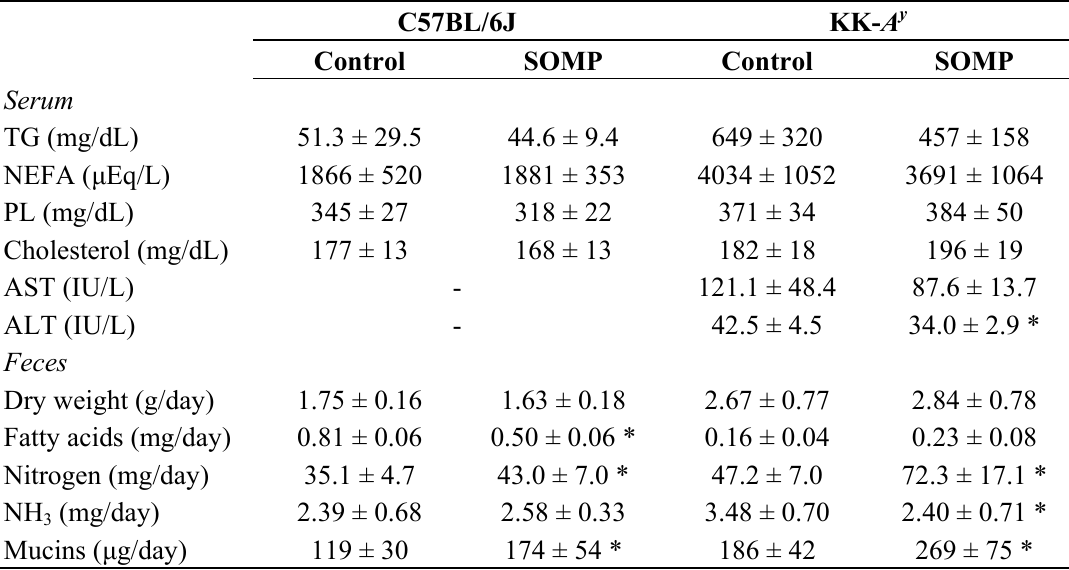
Table 5. Effect of dietary SOMP on serum and fecal biochemical parameters in C57BL/6J and KK- A y